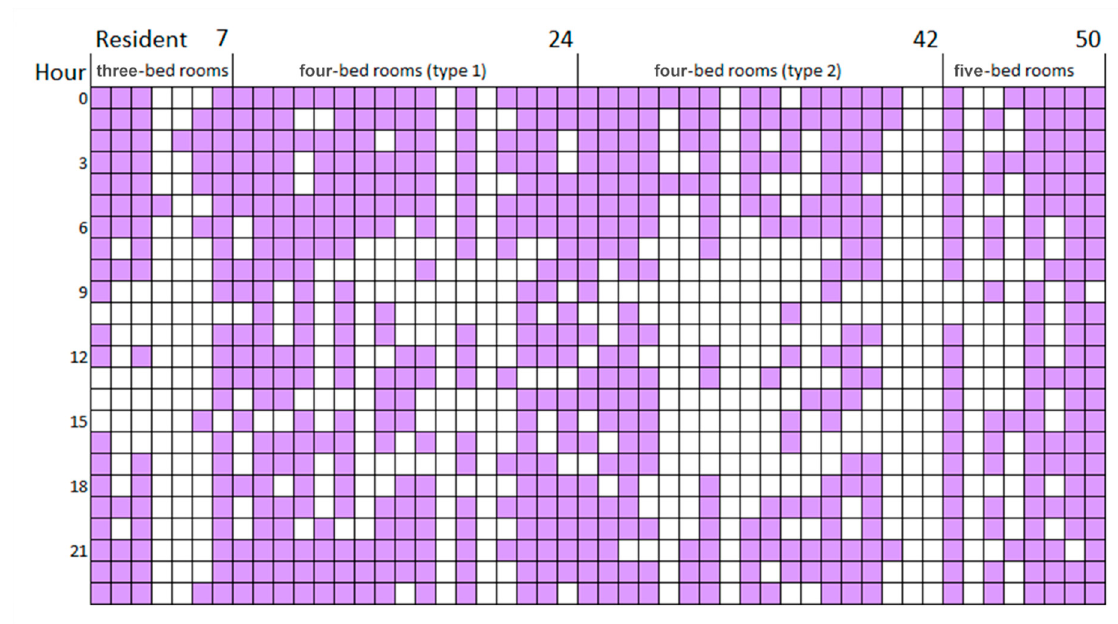
Figure 6. Resident and bedroom relationships. The collective movement patterns show that residents stayed around the bedrooms at 8 a.m. and moved farthest away from the bedroom around 4 p.m: ( a ) at 8 a.m., most residents were located within 5–10 m from their bedrooms; ( b ) at 4 p.m., some residents expanded their mobility range to between 10–20 m.